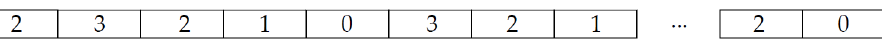
Figure 4. The example of a chromosome.